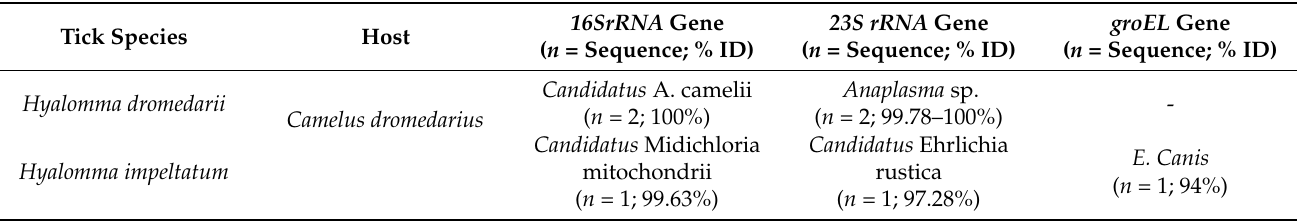
Table 2. Molecular characterization of Anaplasmataceae identified in